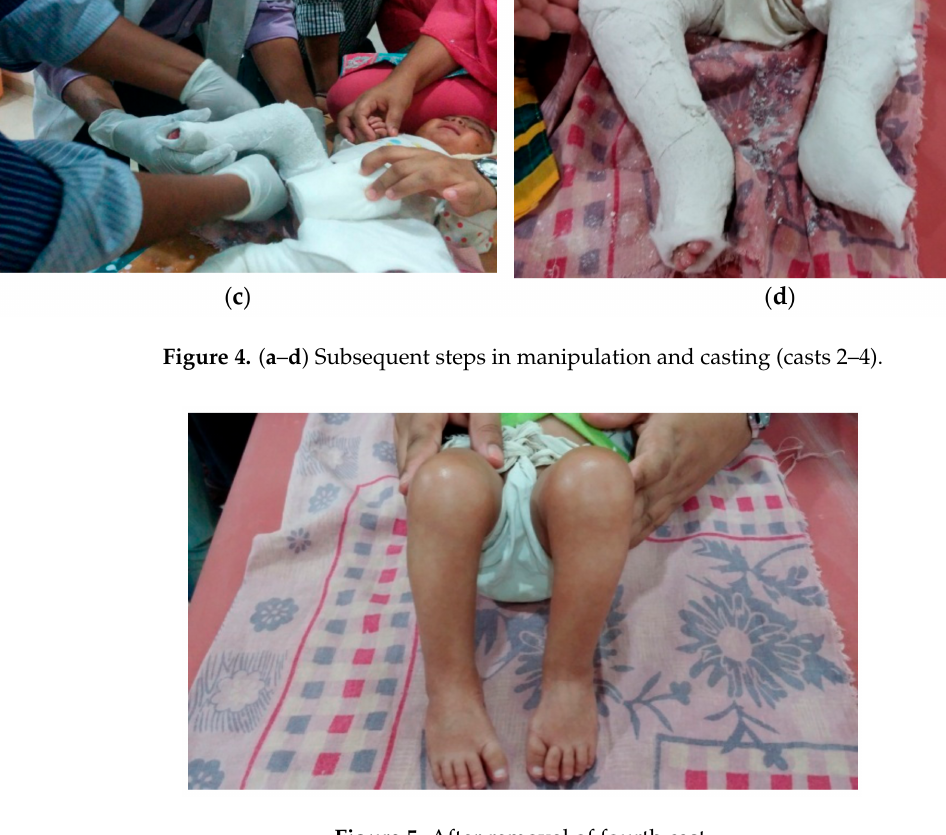
Figure 5. After removal of fourth cast.